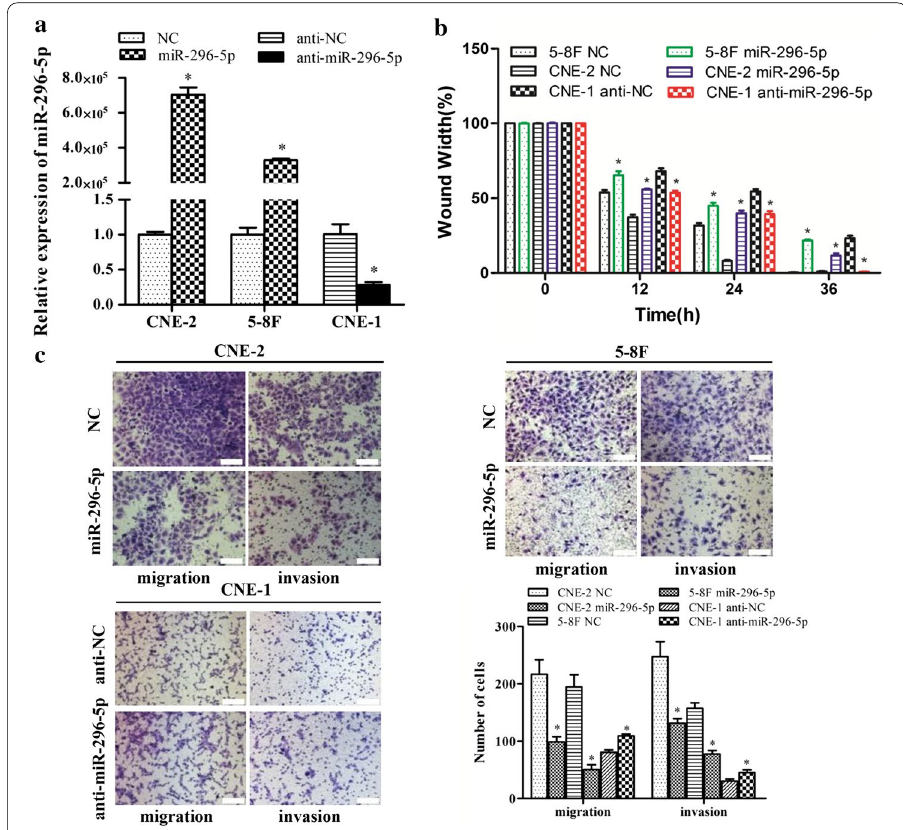
Fig. 2 MiR-296-5p inhibits the migration and invasion of NPC cells in vitro. a MiR-296-5p expression was determined using real-time PCR. b The percentage wound widths for the wound images from wound-healing experiments. c Representative photographs of cells from Transwell assays. Scale bar 100 µm, *p <